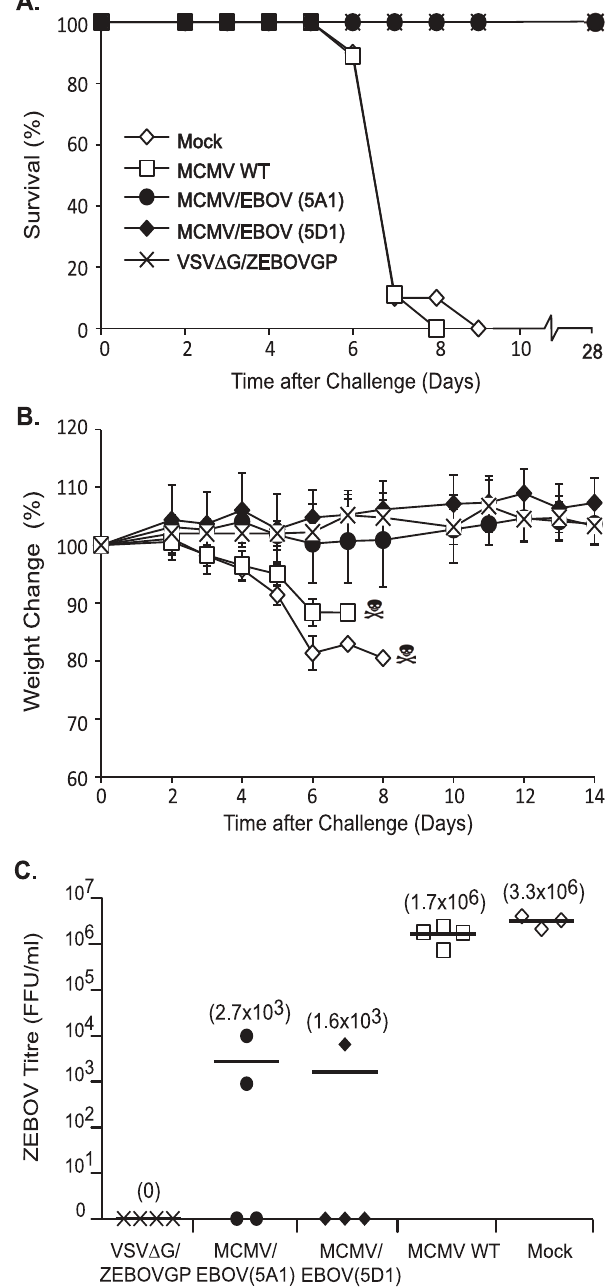
Figure 4. Protective efficacy of MCMV/ZEBOV-NP CTL . Groups of C57BL/6 mice (n=14) were vaccinated by i.p. administration of 5 6 10 5 pfu of either MCMV/ZEBOV-NP CTL (clones 5A1 or 5D1), MCMV WT, or diluent (Mock), followed by an identical boost at week 4. An additional group received VSV D G/ZEBOVGP as a positive control for vaccine efficacy. After 10 weeks (6 weeks after the boost), mice were challenged with 10 3 LD 50 ma-ZEBOV (i.p.). Data represent (a) Percent survival. (b) Body weight change over time post-challenge (error bars show the s.d.). (c) Viremia levels in 3–4 mice harvested at time of peak viremia (day 4) (mean viremia levels for each group are shown in parentheses). For body weight, groups were weighed daily until 14 days post-EBOV challenge, or until all animals in a group had succumb to ZEBOV disease. MCMV/ZEBOV-NP CTL vaccination had a significant impact on survival from ma-ZEBOV challenge compared to MCMV